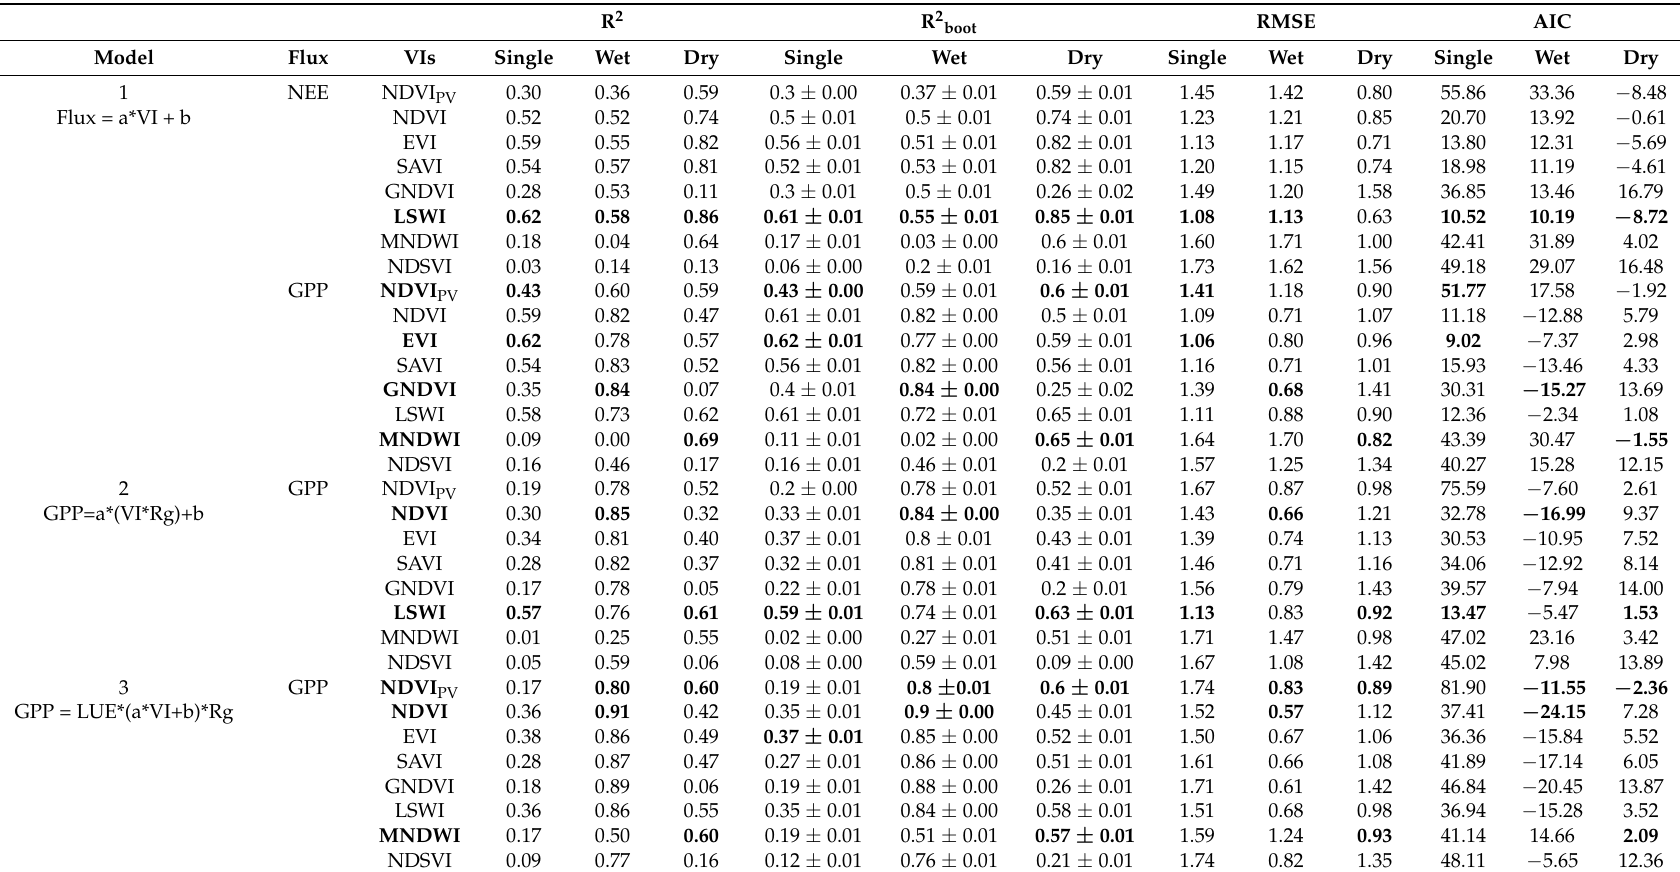
Table 4. GPP~VIs and NEE~VIs regression accuracy metrics (R 2 , R 2 boot , RMSE, AIC) obtained using daily